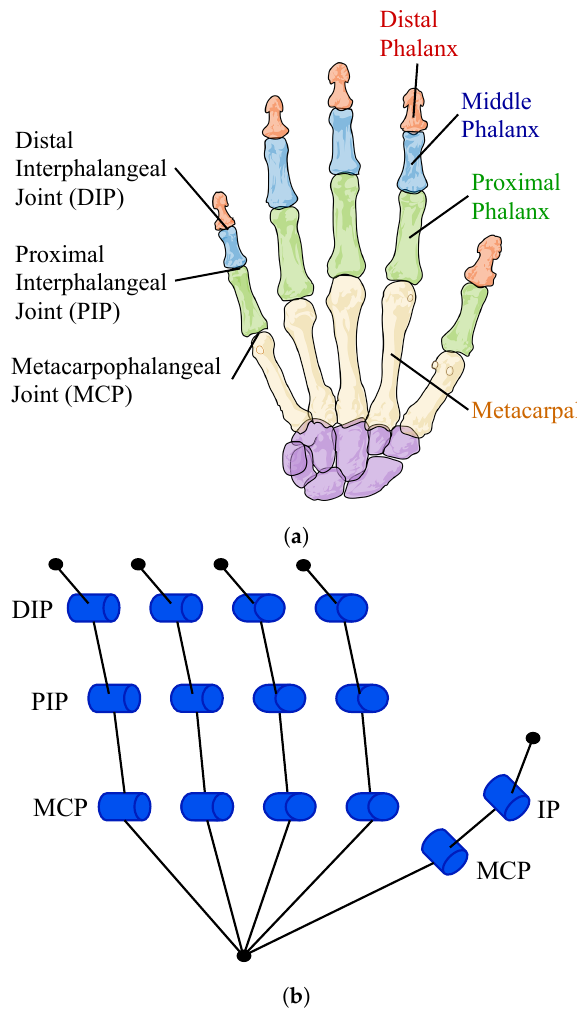
Figure 1. Human hand model. ( a ) Bones and joints of the human hand. ( b ) Simplified 14-DOF model of the proposed soft robotic